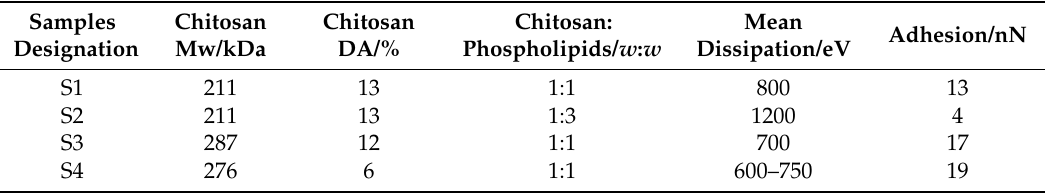
Table 5. Adhesion and dissipation of electrospun Ch / P